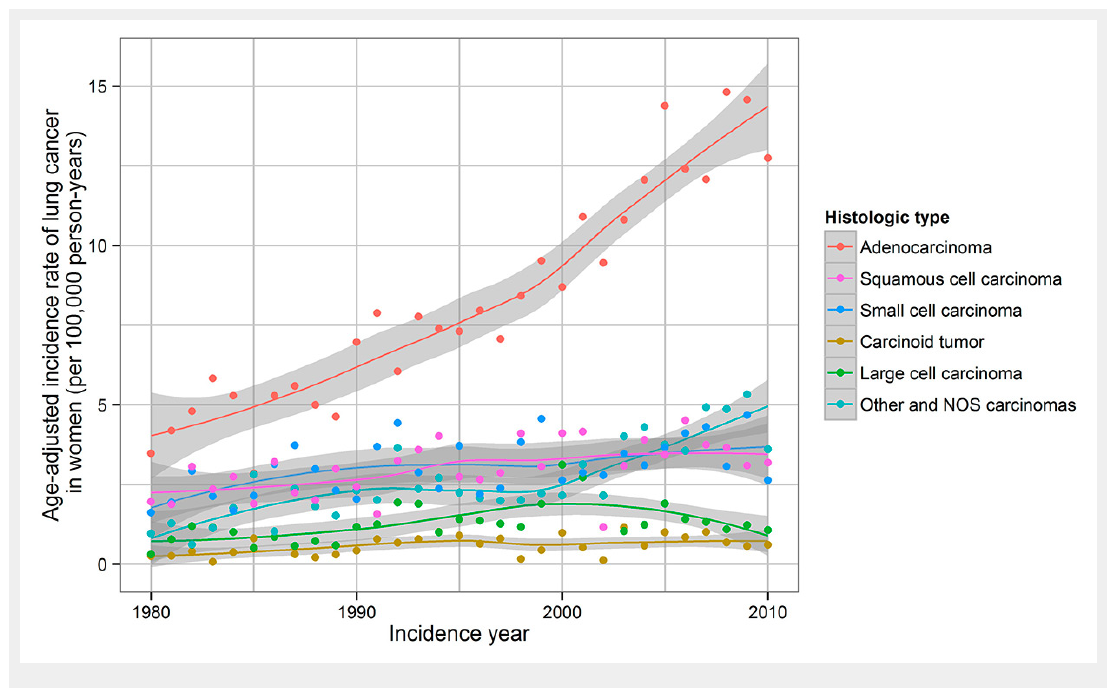
Figure 3 Trends in lung cancer incidence in women by histological type in the Canton of Zurich, Switzerland, 1980–2010. Rates are age adjusted to the standard European population. NOS = not otherwise